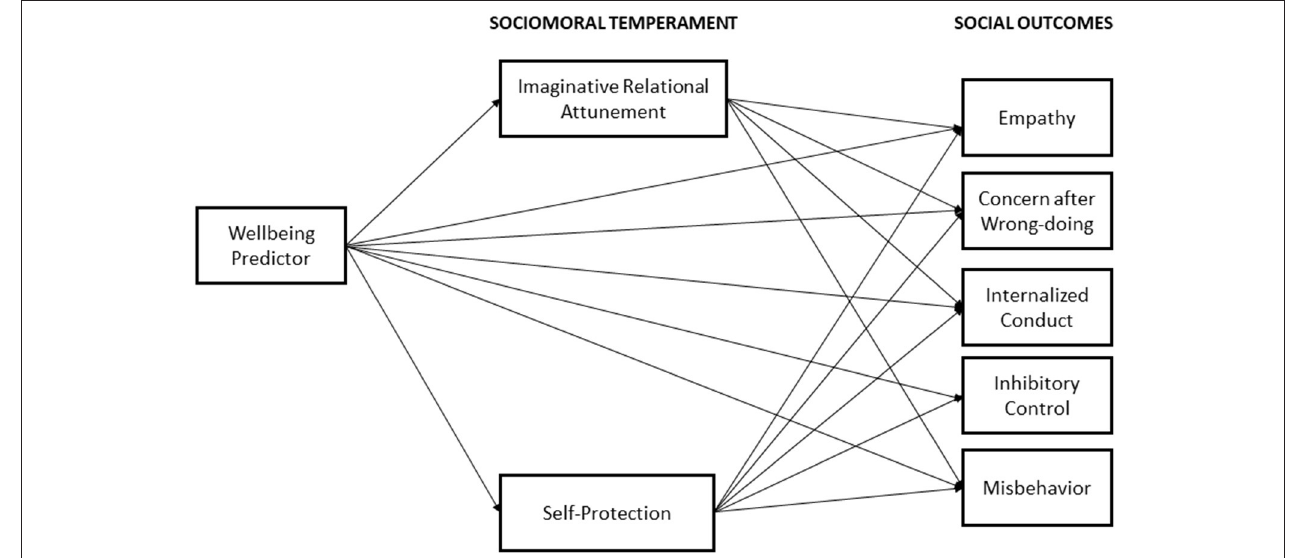
FIGURE 2 | Mediation model with moral temperament mediating relation between wellbeing and social